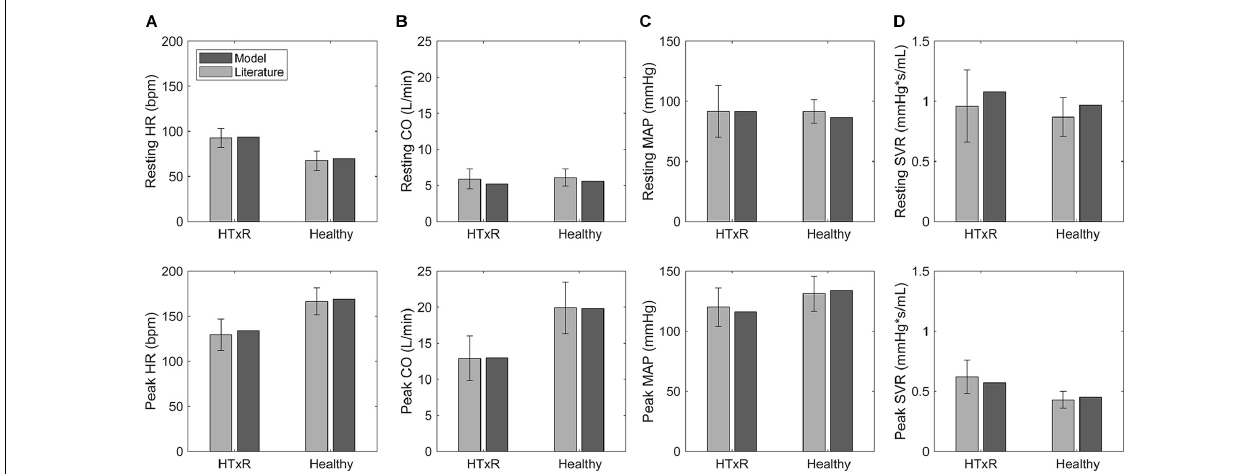
FIGURE 3 | Comparison of selected hemodynamic variables derived from simulations to pooled published data (McLaughlin et al., 1978; Crisafulli et al., 1985; Kavanagh et al., 1988; Labovitz et al., 1989; Wilson et al., 1991; Marzo et al., 1992; Rudas et al., 1993; Kao et al., 1994; Doering et al., 1996; Geny et al., 1996; Notarius et al., 1998; Hayman et al., 2010; Peled et al., 2017; Nygaard et al., 2019; Nytrøen et al., 2019), for HTxRs and the healthy control group, both at rest and during exercise. HR, heart rate (A) ; CO, cardiac output (B) ; MAP, mean arterial pressure (C) ; SVR, systemic vascular resistance (D)